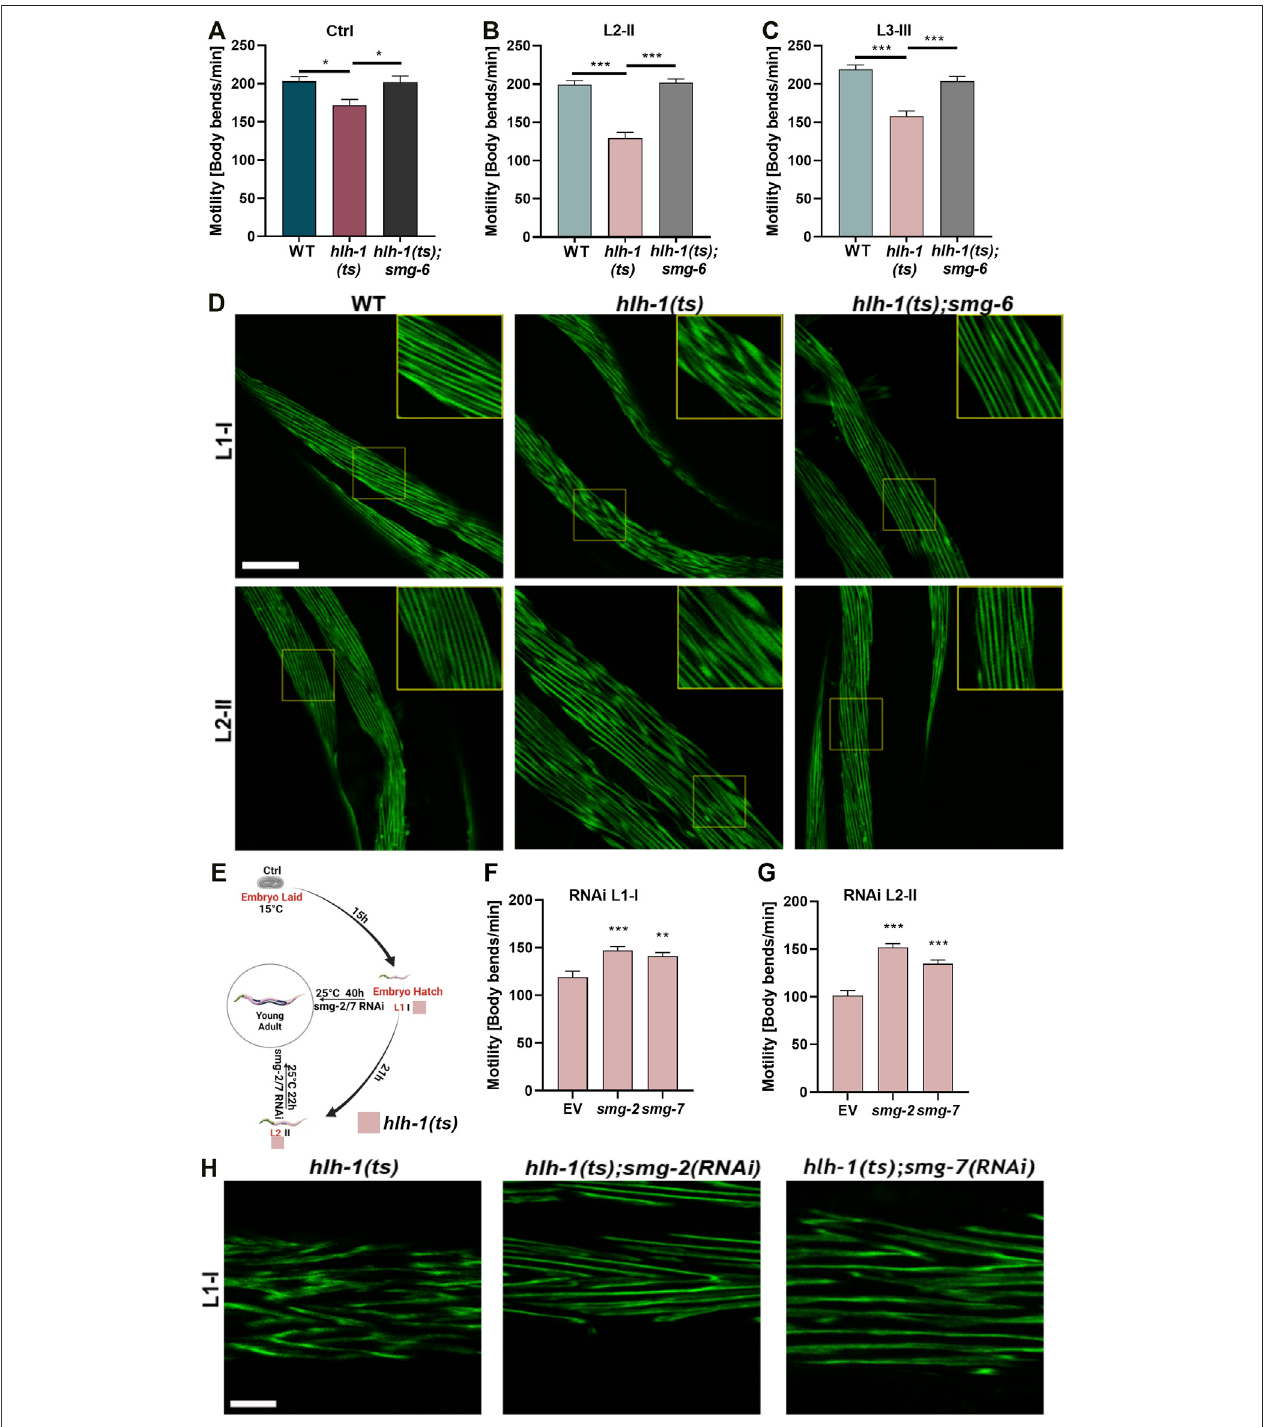
FIGURE 2 | Blocking the RNA-mediated decay pathway rescues animals ’ motility. (A – C) Motility rates of wild type (WT), hlh-1(ts), or hlh-1(ts);smg-6 . Thrashing ratesofage-synchronized WT, hlh-1(ts), or hlh-1(ts);smg-6 grown at 15 ° Cforthe experiment duration (A) or shiftedto25 ° Cat L2[II, (B) ]orL3 [III, (C) ] larvalstages. Data aremeans±1standarderrorofthemean(1SE).Datawereanalyzedusingone-wayANOVAfollowedbyaTukey ’ sposthoctest(N=3, n =20).(*)denotes p < 0.05,and (***) denotes p < 0.001 compared with WT. (D) Representative images of temperature-shifted animals expressing MYO-3:GFP. WT, hlh-1(ts) , or hlh-1(ts);smg-6 animalswereshiftedto25 ° CatL1-IorL2-II.YAwerecollectedand fi xed,andmyo fi lamentswereimaged.Thescalebaris25 μ m.Insertsarea2-foldmagni fi cationofthe boxed area. (E) Schematic representation of the experimental setup. hlh-1(ts) embryos were laid on seeded plates at 15 ° C. Age-synchronized hlh-1(ts) animals were